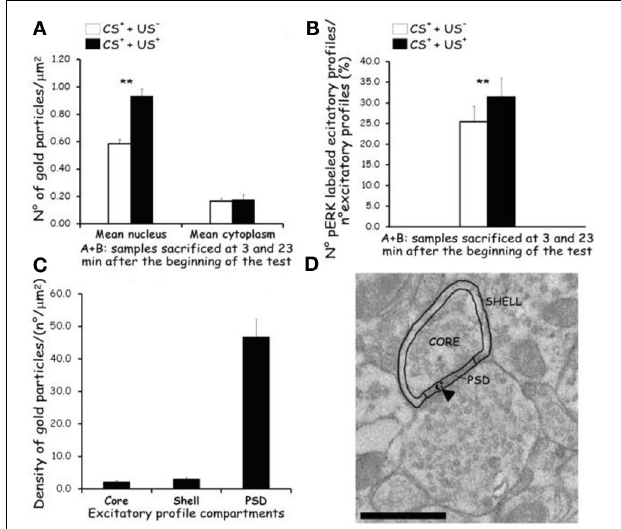
FIGURE 7 | Effects of CTA expression on subcellular p-ERK distribution. (A): histograms showing p-ERK density inside nucleus and cytoplasm of neuron cell bodies belonging to AcbSh of lithium conditioned (CS + -US + ) and control rats (CS + -US − ) ( Expr2 ); histograms represent pooled data obtained from rats sacrificed 3 (group A ) and 23 (group B ) min after the beginning of testing. Values are average + s.e.m. ∗∗ Indicate significant differences ( p < 0 . 01) in average density gold particles between US − and US + rats (One-Way ANOVA). (B): histograms showing the percentage of p-ERK-positive synaptic profiles out of the total number of synapses that were randomly sampled inside the AcbSh of lithium conditioned (CS + -US + ) and control rats (CS + -US − ) ( Expr2 ); histograms represent pooled data obtained from rats sacrificed 3 (group A ) and 23 (group B ) min after the beginning of testing. Values are average + s.e.m. ∗∗ Indicate significant differences ( p < 0 . 01) in number of pERK labeled excitatory profiles (%) between US − and US + rats (One-Way ANOVA). (C,D): sub-synaptic distribution of p-ERK in dendritic spine compartments (core, shell, and PSD). (C): histograms showing the density of gold particles (number of gold particles/ µ m 2 ) observed in each sub-synaptic compartment. (D): Representative TEM micrograph of a dendritic spine subdivided in three compartments: core, shell, and PSD. Arrowhead points to gold particles. Scale bar is 500nm. being presented the sucrose solution (CS) for 20 min (i.e., 30